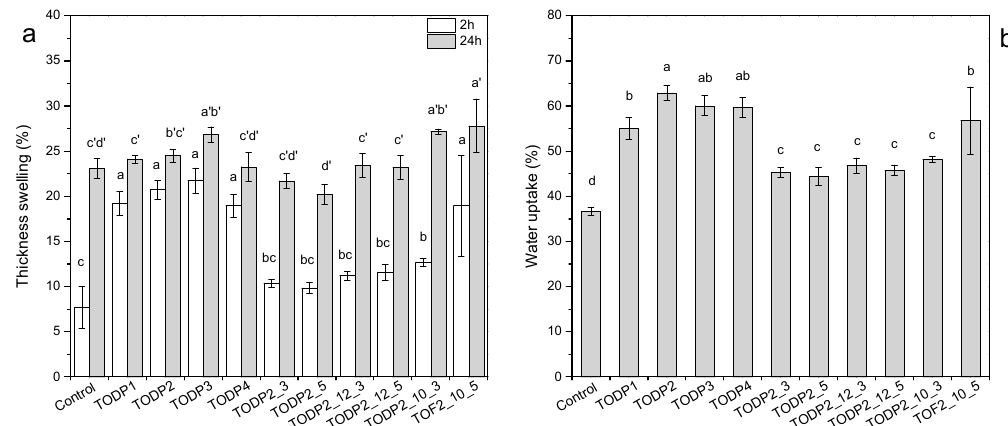
Figure 5. ( a ) The 2 h and 24 h thickness swelling (TS), ( b ) 24 h water uptake of the HDF panels immersed in water. Values labeled with a different letter are statistically different (ANOVA and Tukey’s HSD test) at an error probability of α = 0.05. Error bars represent standard deviations.